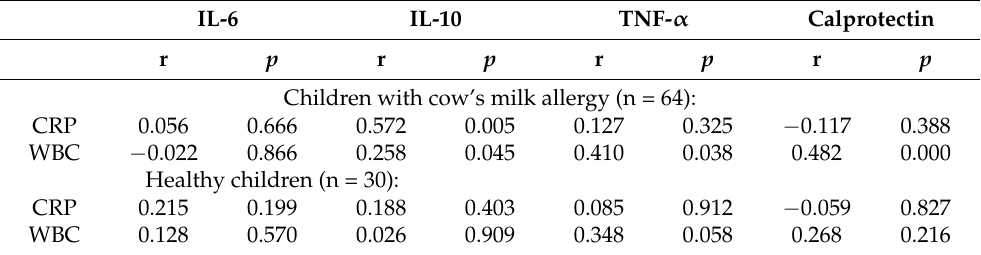
Table 6. Spearman correlations between serum cytokines and calprotectin concentrations and routinely determined parameters (CRP, WBC) in patients with cow’s milk allergy and in healthy children. IL-6 IL-10 TNF- α Calprotectin r p r p r p r p Children with cow’s milk allergy (n = 64): CRP 0.056 0.666 0.572 0.005 0.127 0.325 − 0.117 0.388 WBC − 0.022 0.866 0.258 0.045 0.410 0.038 0.482 0.000 Healthy children (n = 30): CRP 0.215 0.199 0.188 0.403 0.085 0.912 0.827 WBC 0.128 0.570 0.026 0.909 0.348 0.268 0.216